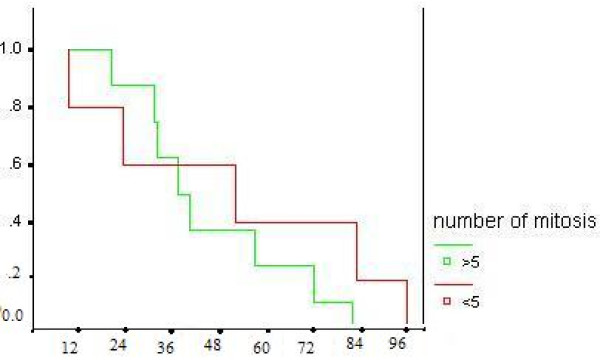
Survival of patients with LGESS based on number of mitosis.